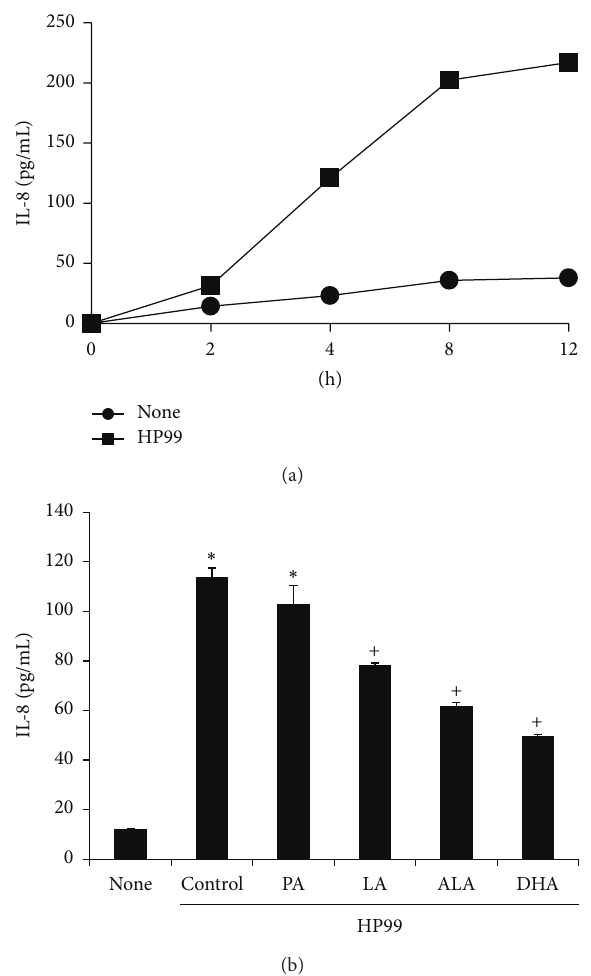
Figure 1: Time-dependent production of IL-8 and effects of PUFAs on H. pylori -infected AGS cells. (a) AGS cells were cultured with H. pylori for the indicated time periods (2, 4, 8, and 12h) and IL-8 levels in the medium was measured by enzyme-linked immunosorbent assay. (b) AGS cells were pretreated with individual fatty acid (100 𝜇 M) for 24 h and cultured with H. pylori for 4 h. Each bar represents mean ± S.E. of four separate experiments. ∗ 𝑃 < 0.01 versus None; + 𝑃 < 0.01 versus